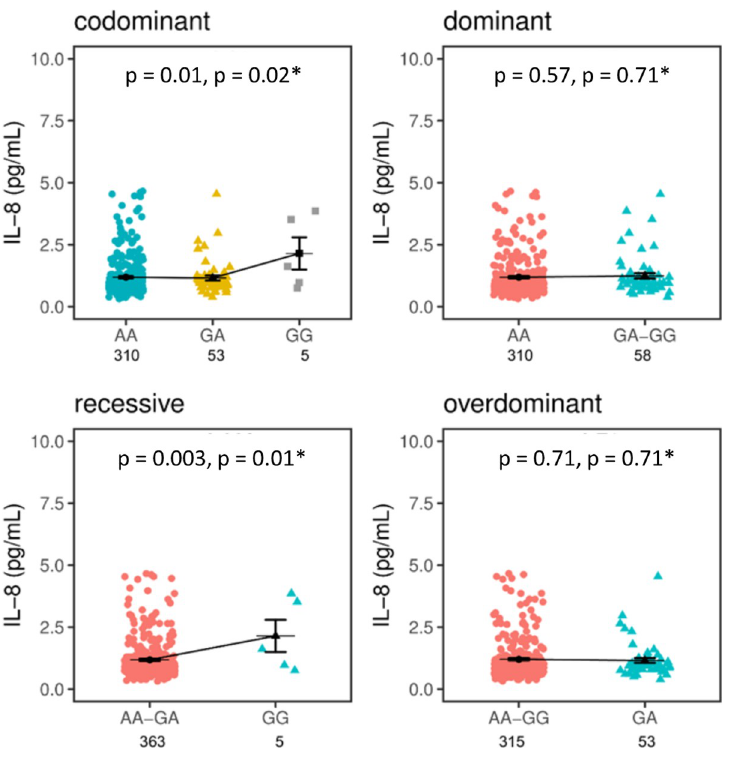
Fig 2. MIRNA499A rs3746444 effects on IL-8 plasma levels in healthy controls. Concentrations of plasma circulating IL-8 were compared between bearers of the AA, AG, and GG genotypes using inheritance models (codominant, dominant, recessive and overdominant). The mean concentrations are displayed in picogram by millilitre (pg/mL) with standard error (SE) of mean. The means are represented by black bars, whereas SE are represented by error bars. � Corrected for Benjamini-Hochberg False Discovery Rate assuming four tests. p < 0.05 is statistically significant. https://doi.org/10.1371/journal.pntd.0009795.g002 homozygotes individuals (GG = 0.64 ± 0.18 pg/mL versus AA = 0.41 ± 0.01 pg/mL; p = 0.09) (Fig 3 ) . Similarly, MIR499A rs3746444 have a tendency on influencing the plasma circulating levels of IL-17 among the HC. GG homozygotes (5.48 ± 1.97 pg/mL) have higher levels of IL-17